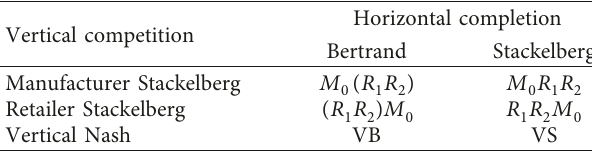
Table 2: Six game models with different power structures. Vertical